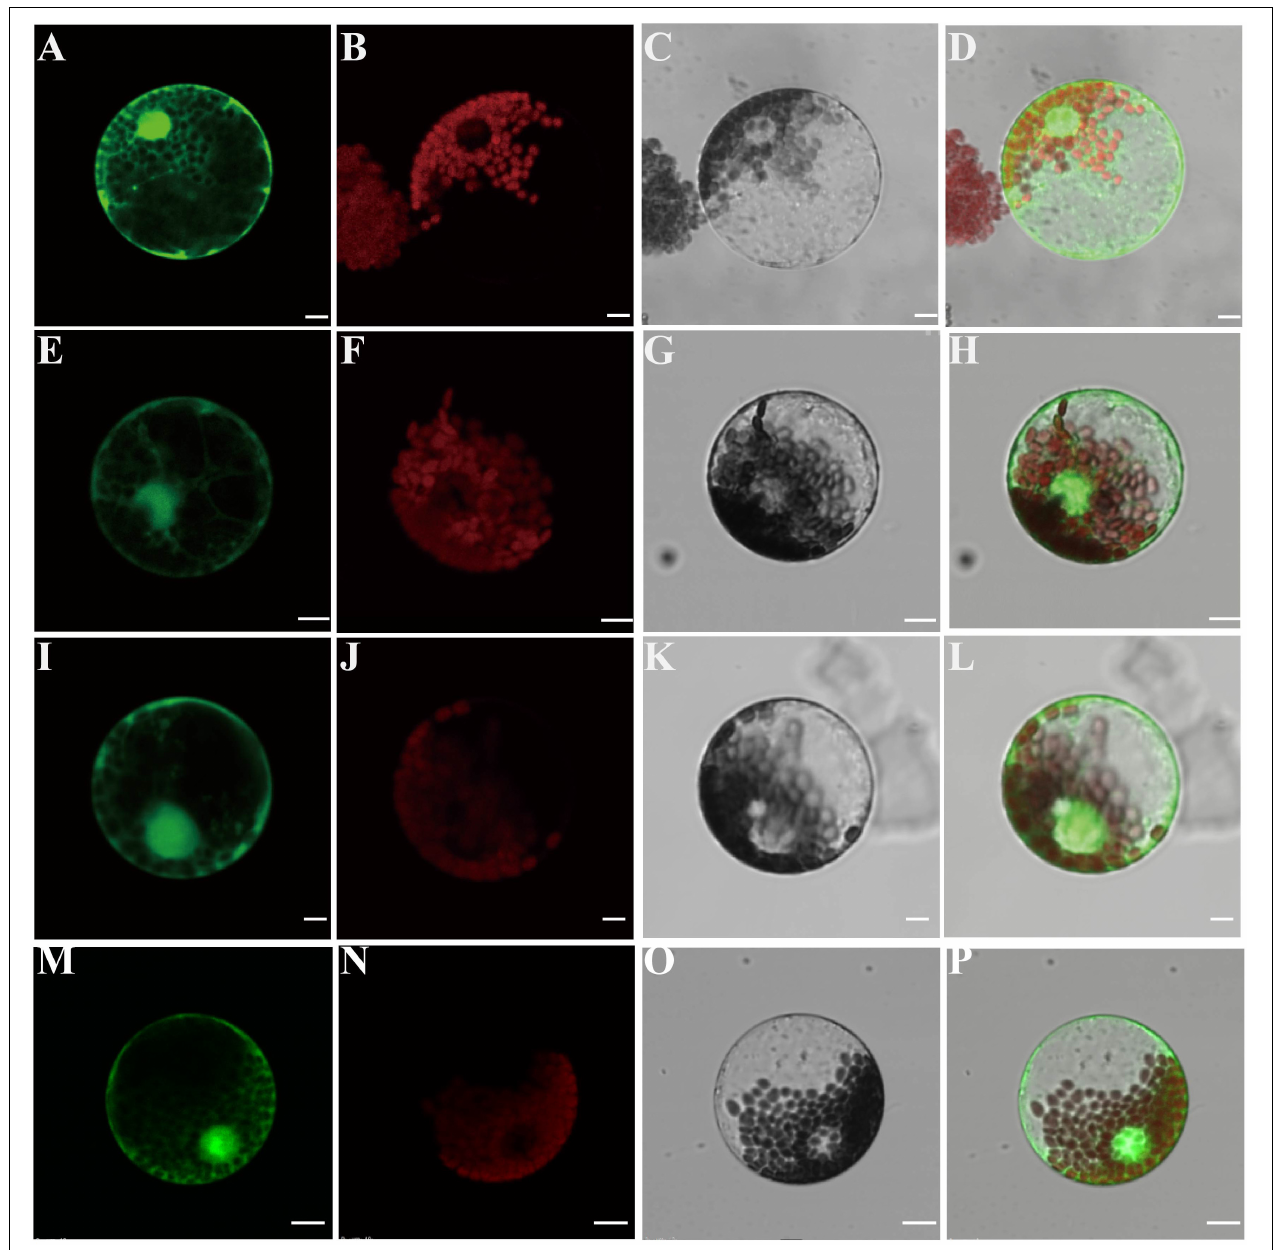
FIGURE 3 | The TaCCA1 proteins are mainly localized in the nucleus. (A–D) Wheat protoplasts expressing green fluorescence protein (GFP) alone. (A) Green fluorescent protein (GFP) fluorescence. (B) Autofluorescence of chloroplasts. (C) Bright-field image of GFP. (D) Merged image of (A–C) . (E–H) Wheat protoplasts cell expressing the TaCCA1-7A-GFP fusion protein. (E) GFP fluorescence. (F) Autofluorescence of chloroplasts. (G) Bright-field image of GFP. (H) Merged image of (E–G) . (I–L) Wheat protoplasts cell expressing the TaCCA1-7B-GFP fusion protein. (I) GFP fluorescence. (J) Autofluorescence of chloroplasts. (K) Bright-field image of GFP. (L) Merged image of (I–K) . (M–P) Wheat protoplasts cell expressing the TaCCA1-7D–GFP fusion protein. (M) GFP fluorescence. (N) Autofluorescence of chloroplasts. (O) Bright-field image of GFP. (P) Merged image of (M–O) . Scale bars = 10 µ